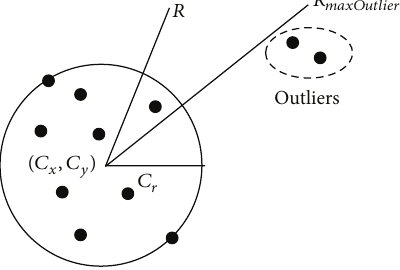
Figure 12: A V-formation with two outliers.